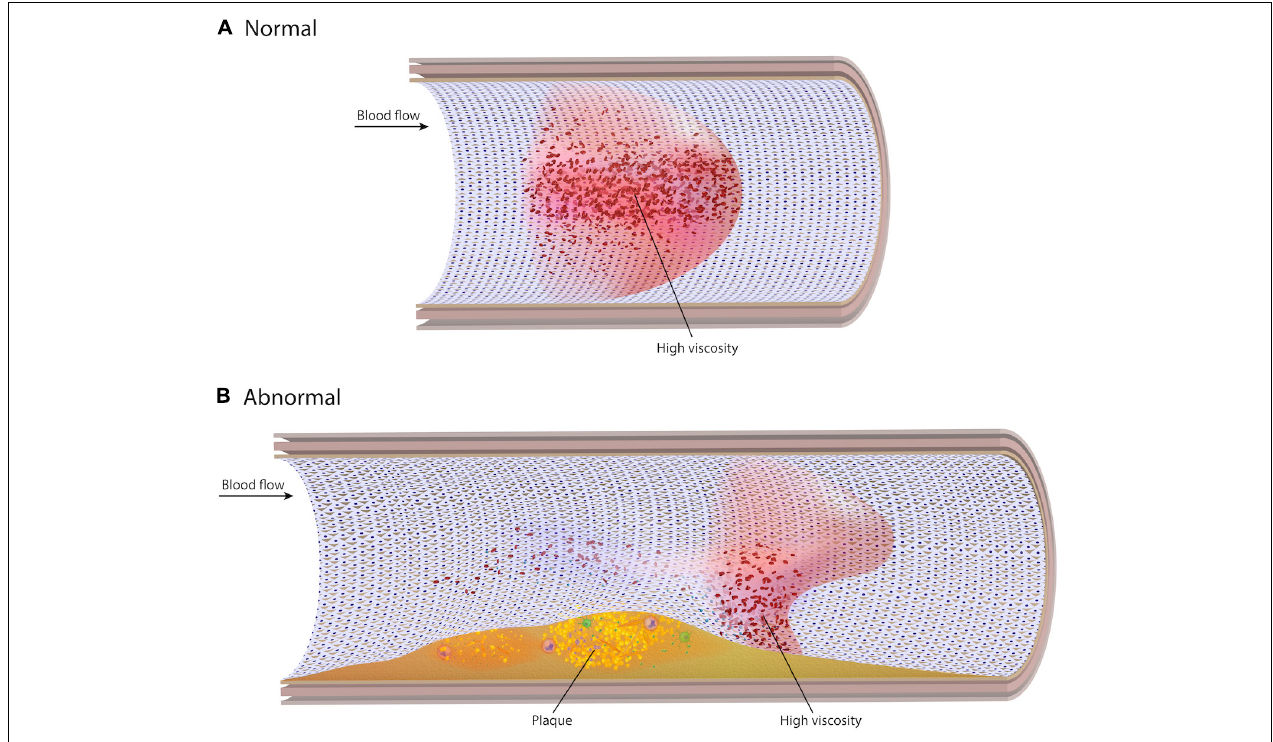
FIGURE 1 | Normal and abnormal viscosity profiles. (A) In a straight unobstructed artery, blood velocity takes on a parabolic profile with low shear rate (high viscosity) in the centre of the artery and low viscosity at the wall. (B) In the presence of stenoses, curvatures, or bifurcations, the blood velocity profile becomes distorted. Localized regions of low shear rate can develop at the wall, resulting in high viscosity near the endothelial surface.